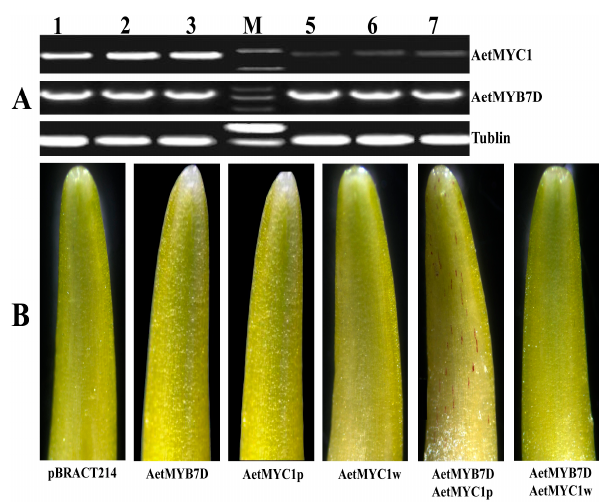
Figure 4. Functional verification of AetMYC1 and AetMYB7D . ( A ) Expression profiles of AetMYC1